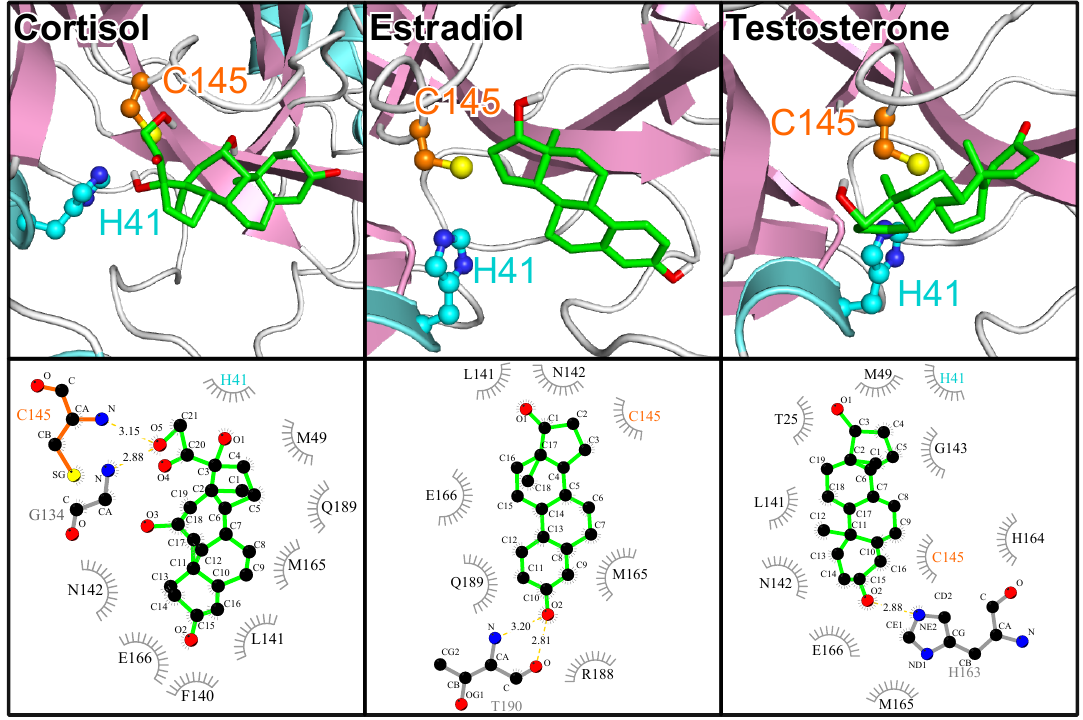
Figure 9. The poses and 3CL pro –compound interactions for three selected natural steroids. ( Top ) The binding poses of cortisol, estradiol, and testosterone are shown, using the same protein and ligand representations as well as color scheme as in Figure 1. ( Bottom ) The interactions were analyzed and plotted with LigPlot+ [36,37]. Hydrogen bonds are indicated by orange dashed lines between the atoms involved and the donor–acceptor distance is given in Å, while hydrophobic contacts are represented by gray arcs with spokes radiating towards the ligand atoms they contact. The contacted atoms are shown with spokes radiating